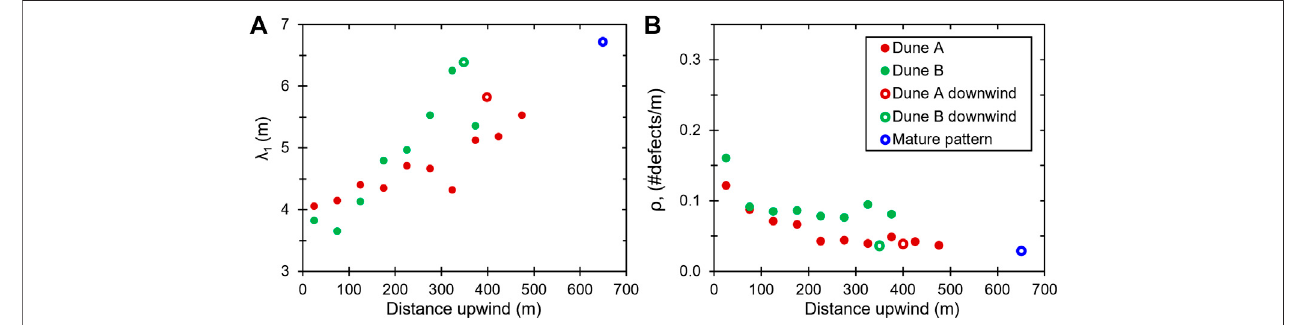
FIGURE 5 | A general trend toward bedform maturity along the dune wakes is shown by their (A) mean bedform spacing ( λ 1 ) and (B) defect density ( ρ ). Also included are areas downwind of each dune (indicating initial conditions for each wake), and the region adjacent to the Dune A wake with a relatively mature pattern (see Figure 4A ), placed at their respective distances from the nearest downwind dune (Dunes C, D, and E,